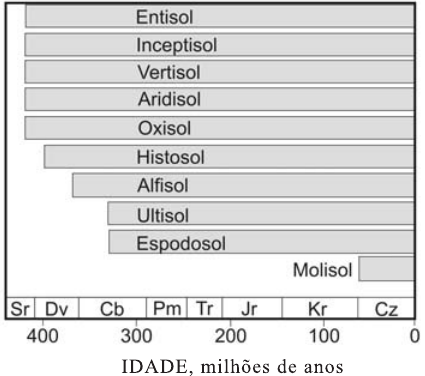
Figura 1. Ordens de solos e respectivas origens no registro geológico (Classificação